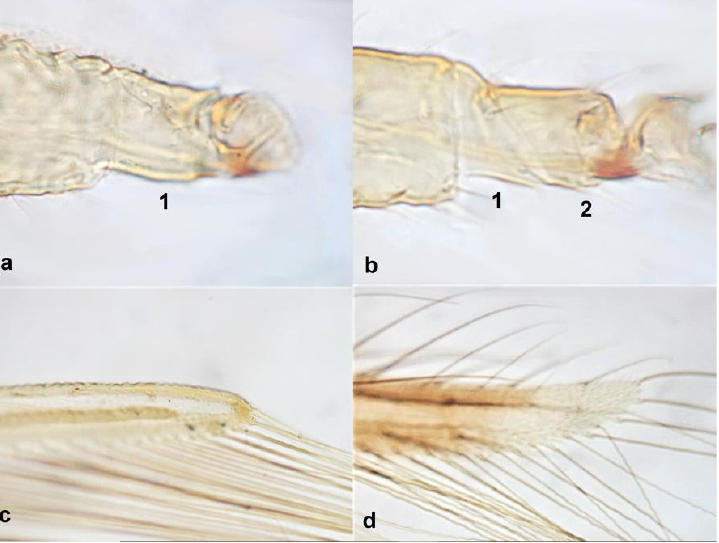
Figure 18. Fore wing ( a , b ): ( a ) one row of postero-marginal cilia; ( b ) two rows of postero-marginal cilia; terminal antennal segments ( c , d ): ( c ) ending in a sharp point; ( d ) not ending in a sharp point. 18 Fore tarsi one-segmented (Figure 19a); fore wings uniformly light brown; postero- marginal cilia straight (Figure 19c); fore wing apex rounded (Figure 19c) ........................... ................................................................................... Heliothrips haemorrhoidalis (Bouch è ) Fore tarsi two-segmented (Figure 19b); fore wings brown with white stripes; postero- marginal cilia wavy (Figure 19d); fore wing apex pointed (Figure 19d) ......................